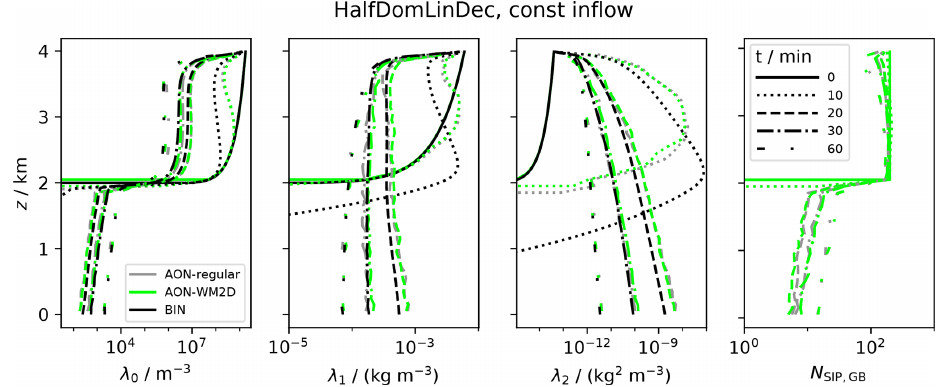
Figure 10. HalfDomLinDec set-up: vertical profiles of moments λ 0 , λ 1 , λ 2 and N SIP,GB for various model versions (AON-WM3D, AON- WM2D, BIN; see colour legend in left-most panel) and times (0, 10, 20, 30, 60min; see line style legend in right-most panel).